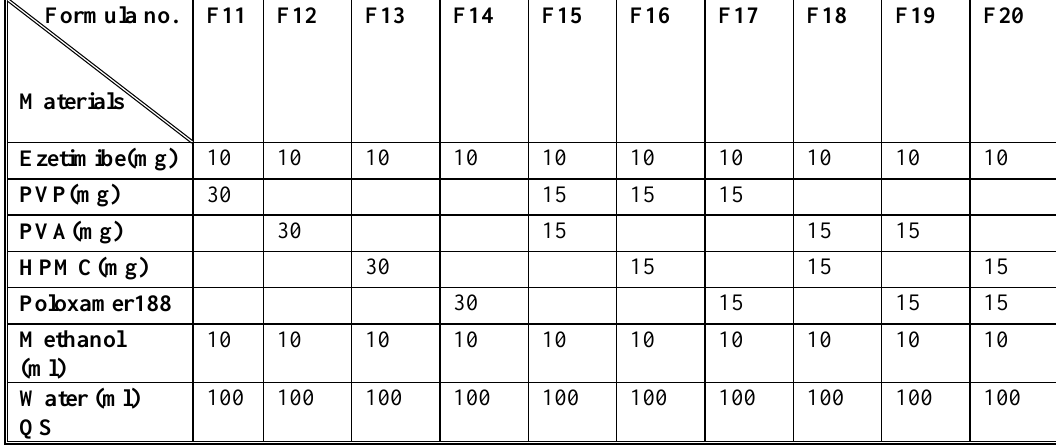
Table (2): Composition of ezetimibe nanosuspension using different types of stabilizers at drug: stabilizer ratio